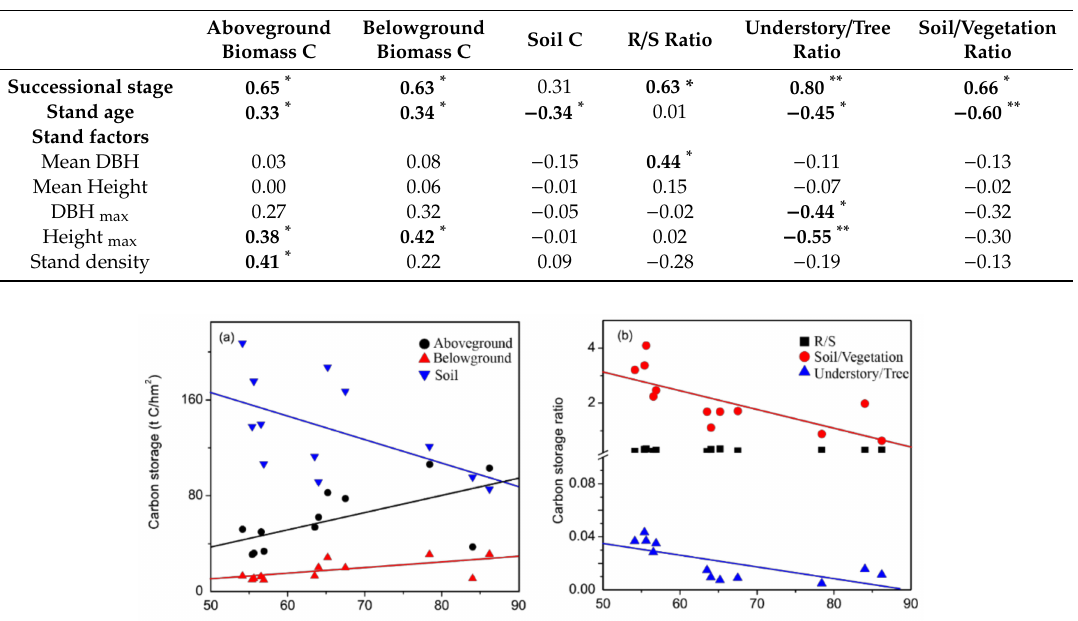
Table 3. The R 2 of each variable in explaining carbon storage and allocation pattern, “ − ” for negative relationships while others were positive ones (* p < 0.05; ** p < 0.01).